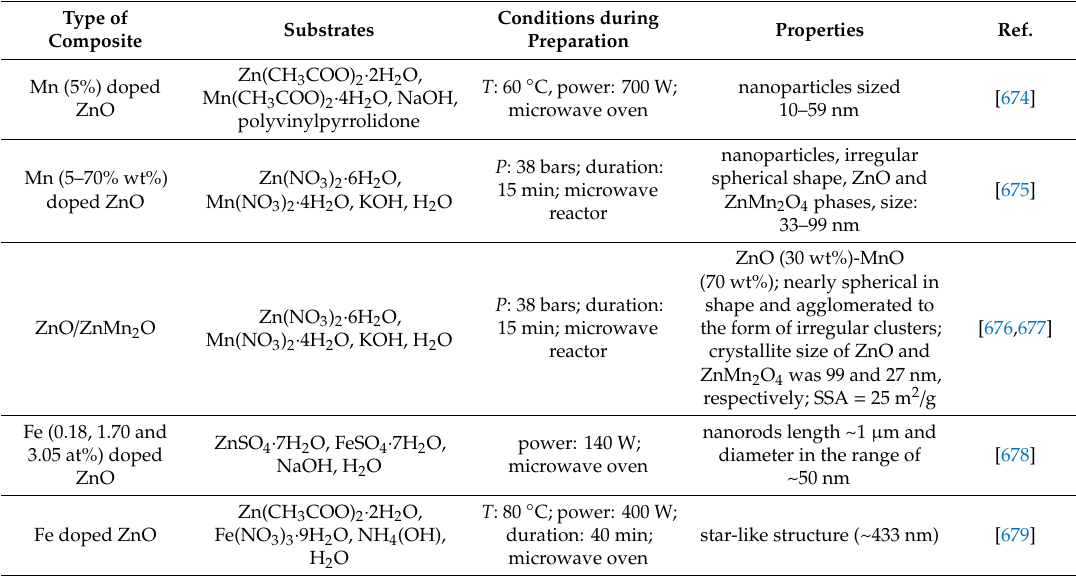
Table 7. Summary of the microwave hydrothermal synthesis of ZnO nanocomposites or ZnO hybrid nanostructures without any additional heat treatment.